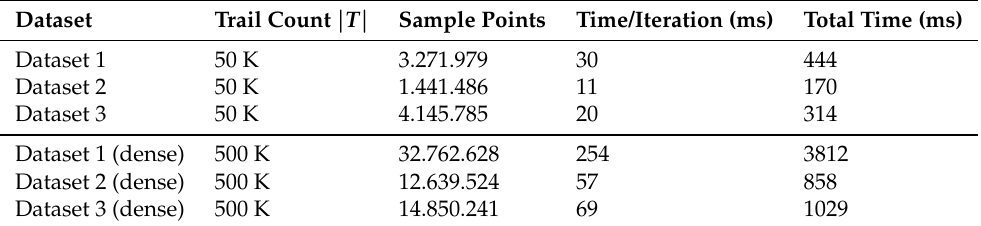
Table 2. End-to-end execution times of the proposed visualization pipeline for several datasets.